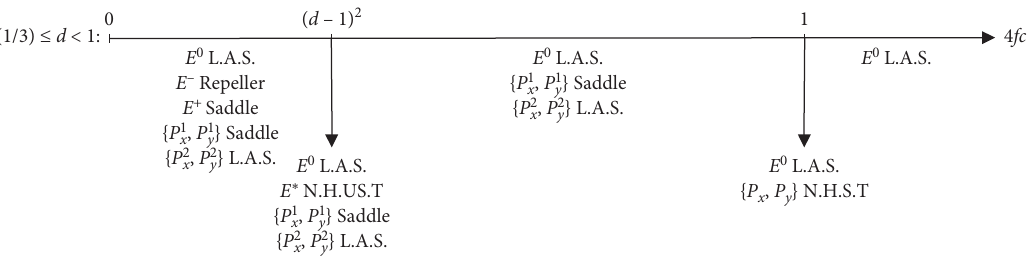
Figure 2: Bifurcation diagram of global dynamics of equation (1) in the parametric region 1/3 ≤ d < 1 for different values of the bifurcation parameter 4 fc .